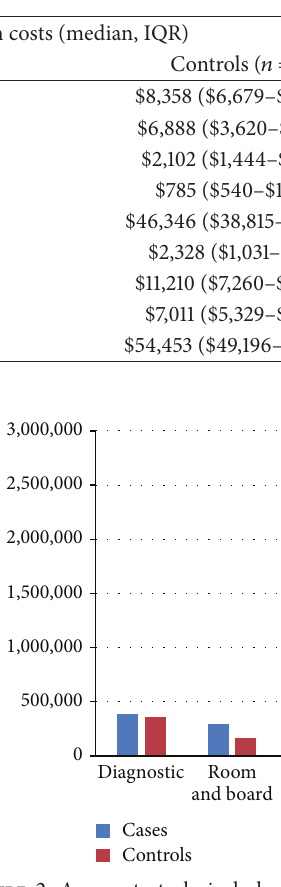
Figure 1: Aggregate professional charges for cases and controls are broken down into surgical, radiology, EM (evaluation and management), and total charges. Median values are reported.